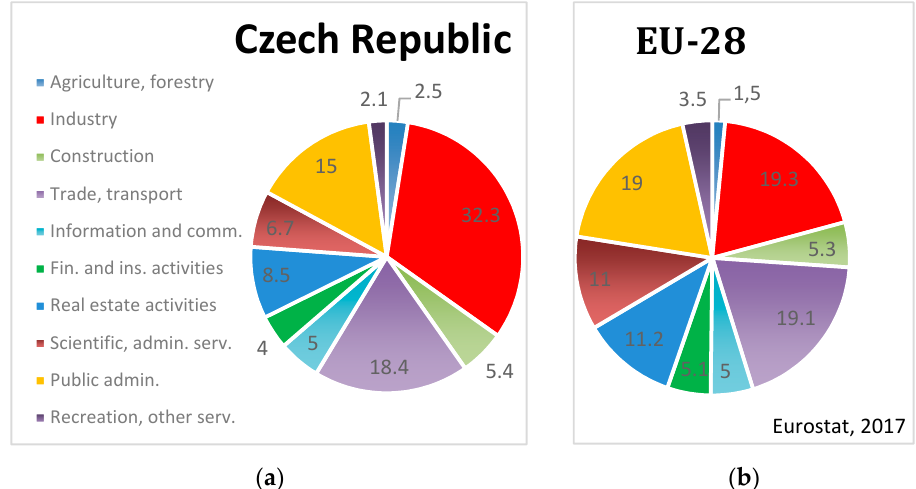
Figure 1. Composition of gross domestic product (GDP) in the Czech Republic ( a ) and comparison to the average of 28 countries within the European Union ( b ) as of 2016. Fully inclusive legend is as follows: Agriculture, forestry: agriculture, hunting, forestry, and fishing; Trade, transport: distributive trade,